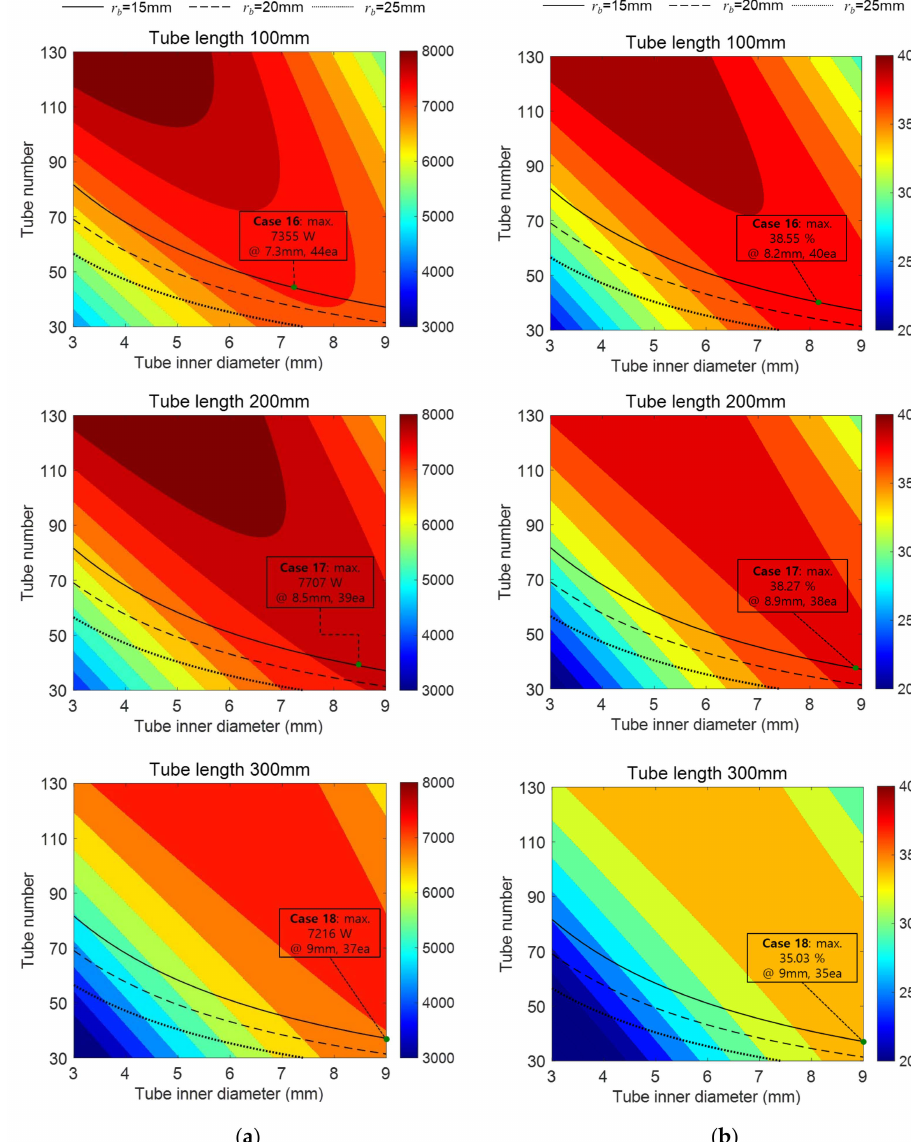
Figure 11. Predicted ( a ) brake power and ( b ) efficiency according to the inner tube diameter and the number of tubes using the regression